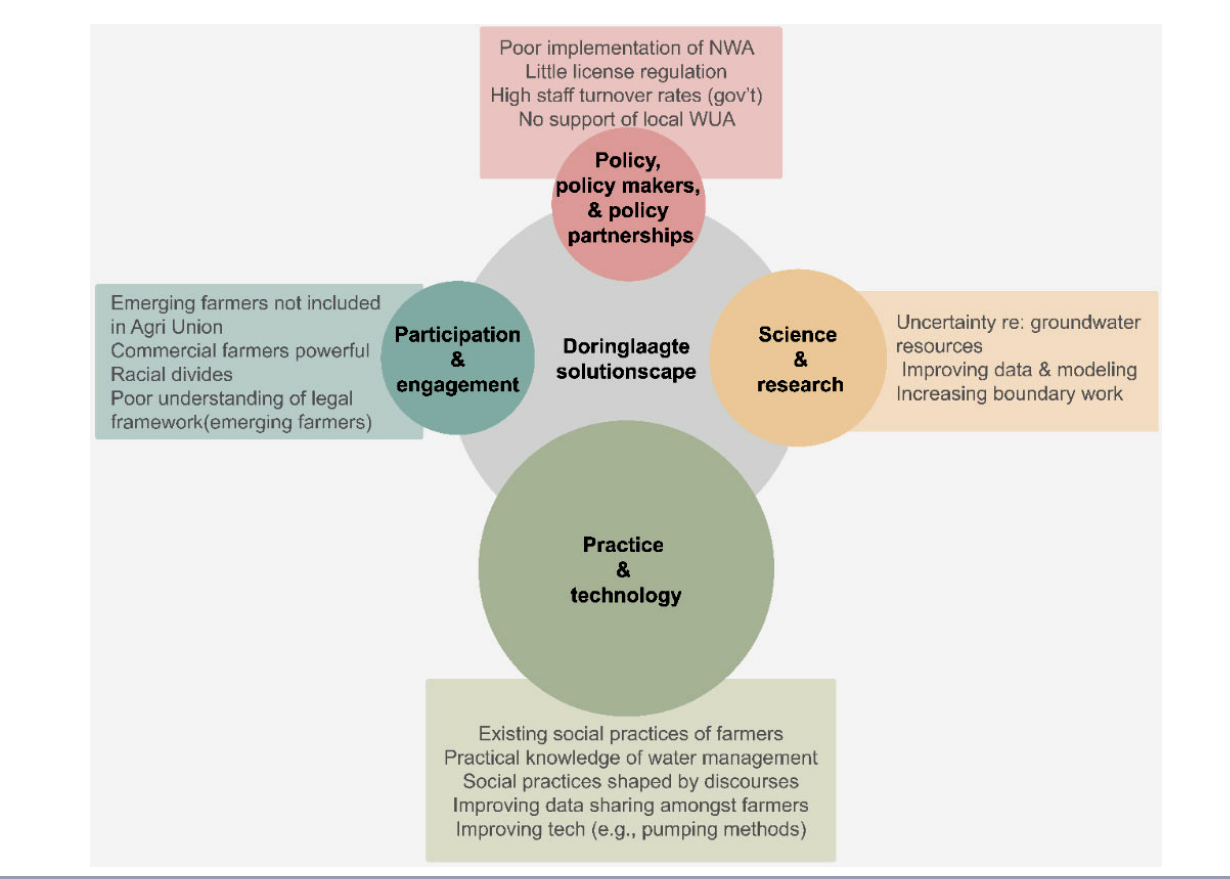
Fig. 3 . Solutionscape expression in the Doringlaagte case study. NWA = National Water Act; WUA = water user